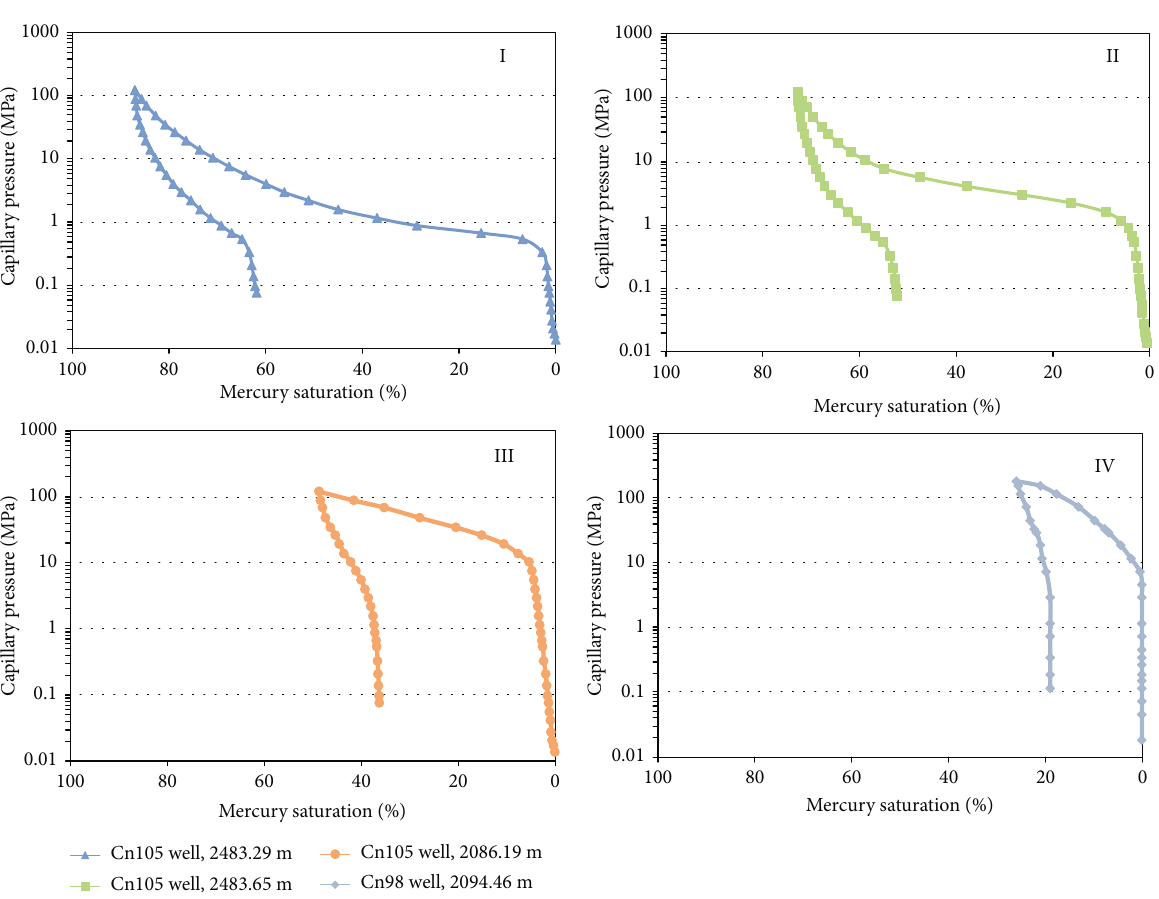
Figure 5: Pictures of pore and cement in scanning electron microscope. (a) Intergranular pore, Cn109 well, 2221.37m. (b) Illite and quartz dissolution, Cn105 well, 2482.84m. (c) Illite and chlorite, Cn105 well, 2482.99m. (d) Chlorite and intercrystalline pore, Cn93 well, 2276.68m. (e) Authigenic quartz, Cn105 well, 2483.14m. (f) Kaolinite and illite, Cn105 well, 2483.14m. (g) Chlorite, Cn105 well, 2487.58m. (h) Calcite, Cn105 well, 2487.26m. (i) Kaolinite, Cn 98 well, 2091.57 m.